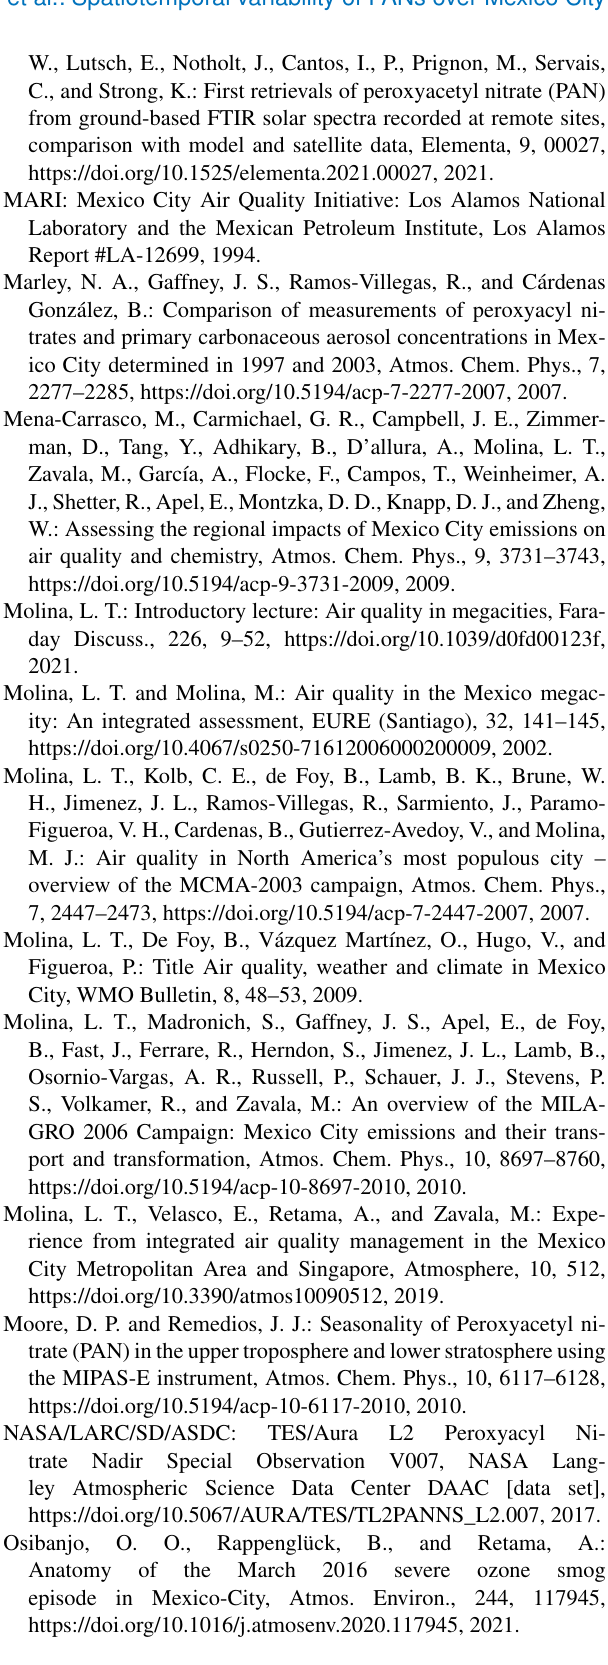
Figueroa, P.: Title Air quality, weather and climate in